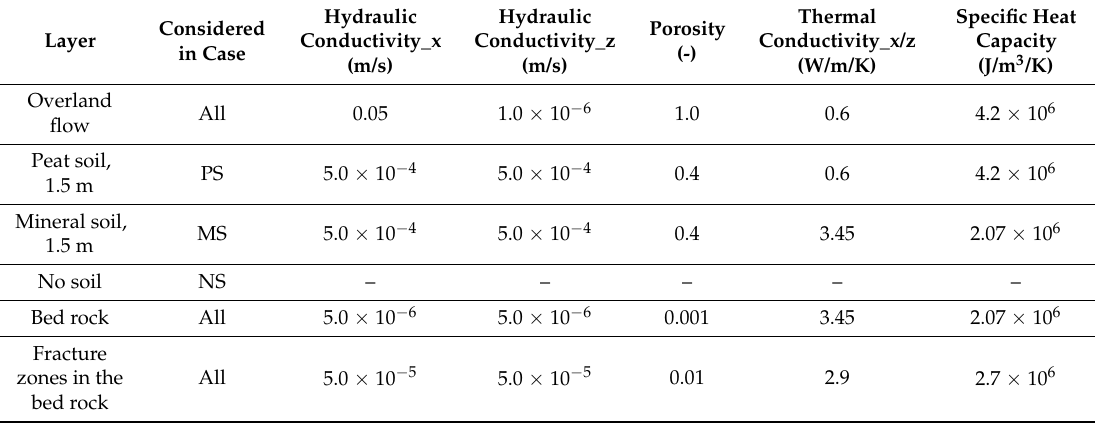
Table 1. Hydraulic and thermal properties used in the simulation cases of no soil (NS), mineral soil (MS), and peat soil (PS) above bedrock with two main fracture zones (Figure 2a).